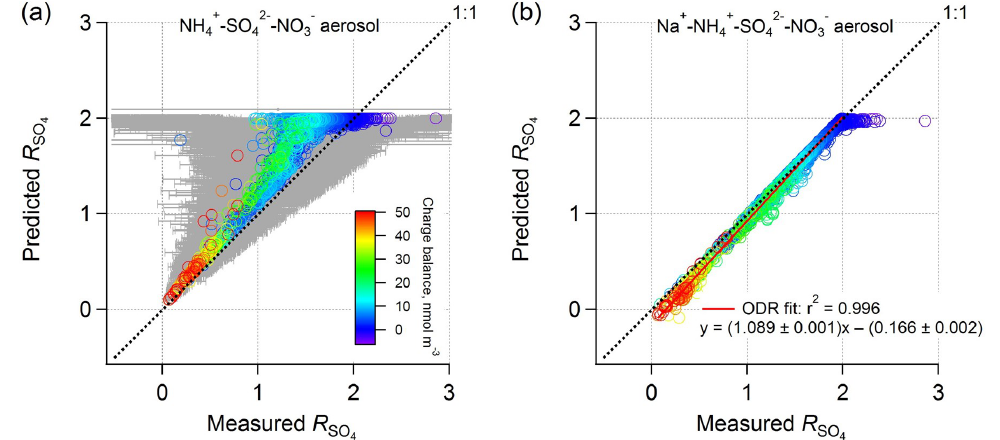
= (NH + − NO − / SO 2 − ) (molmol − 1 ), ( R SO and AMS-measured R SO 4 3 4 4 4 4 , SO 2 − , and NO − aerosol and (b) Na + , NH + , SO 2 − , and NO − aerosol, and both 4 4 3 4 4 3 , SO 2 − , and NO − (Bahreini et al., 2009). Error bars are larger at higher 4 4 3 levels 4